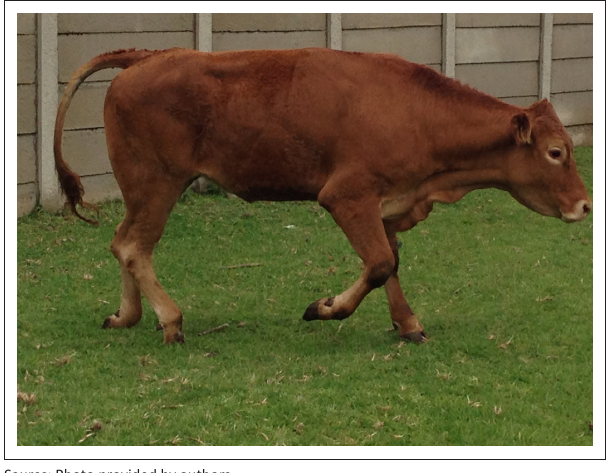
FIGURE 1: An affected heifer exhibiting flexion (over-knuckling) of the fetlocks.